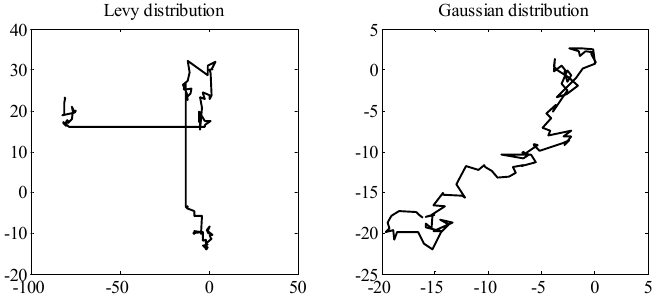
Figure 2. Trajectories based on Lévy distribution and Gaussian distribution (starting from the origin).